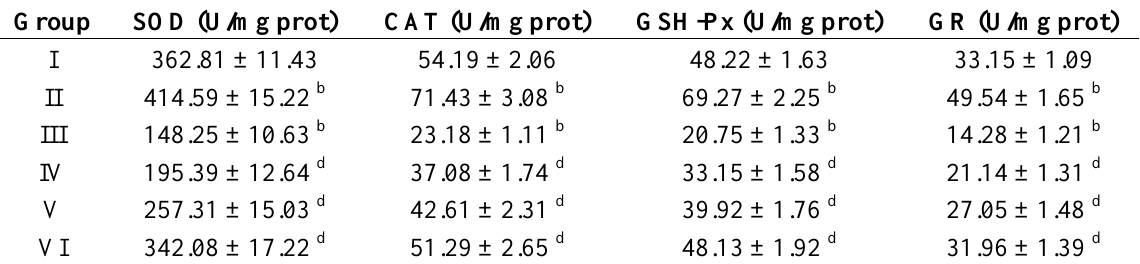
Table 7. Effect of tea polyphenol on liver superoxide dismutase (SOD), catalase (CAT), glutathione peroxidase (GSH-Px) and GR